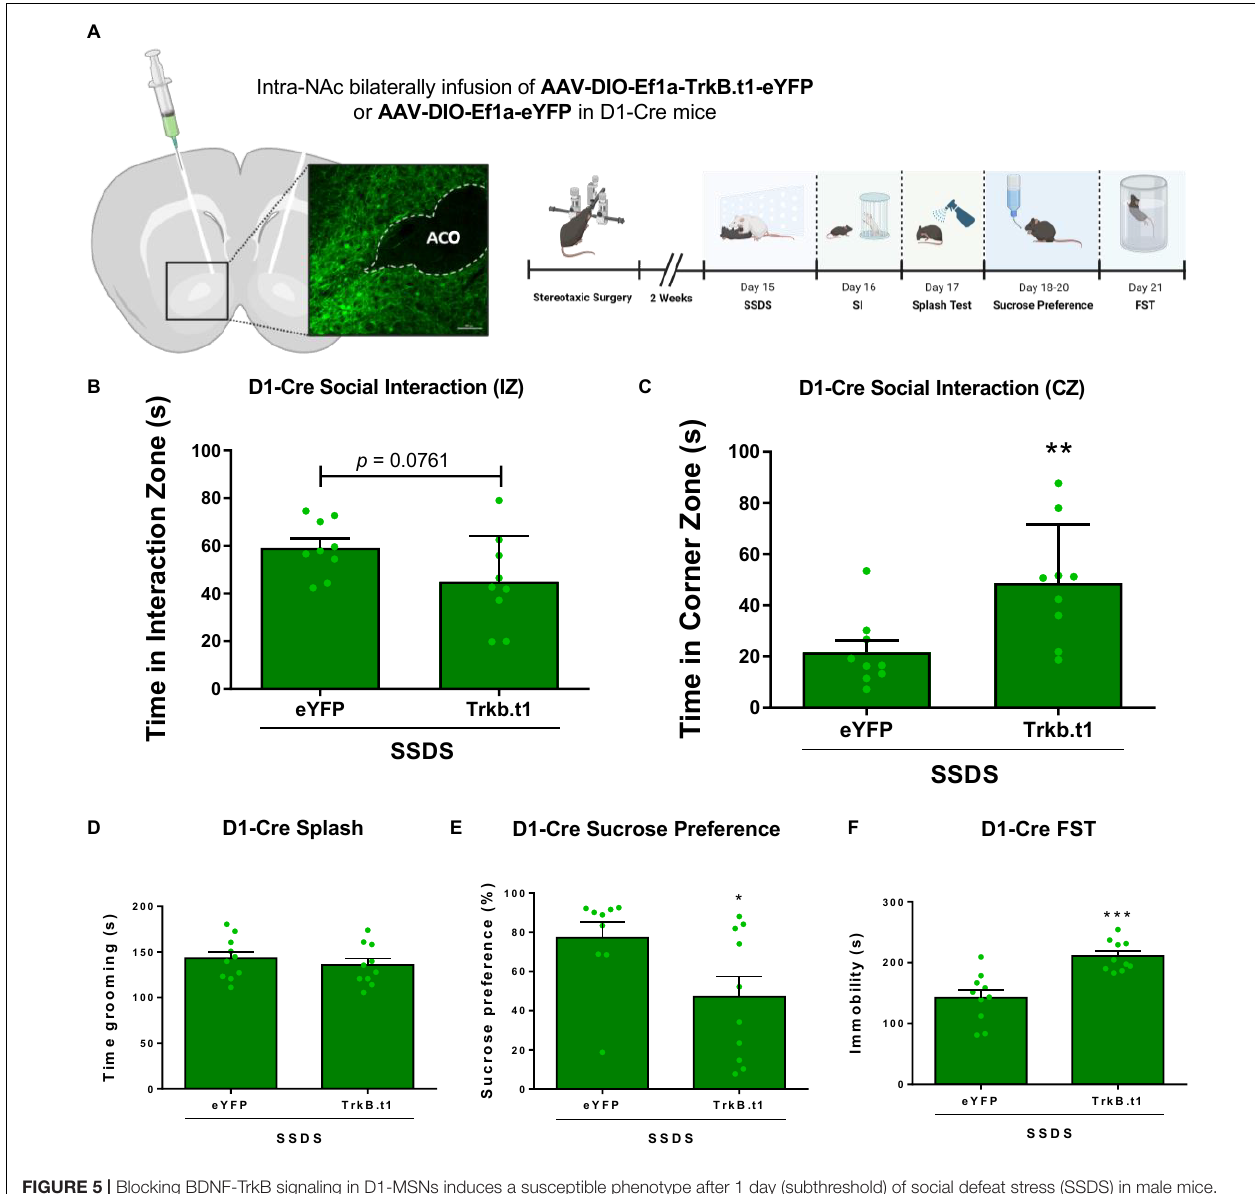
FIGURE 5 | Blocking BDNF-TrkB signaling in D1-MSNs induces a susceptible phenotype after 1 day (subthreshold) of social defeat stress (SSDS) in male mice. (A) Viral vectors and image demonstrating the viral injection, with EYFP expression virus, scale bar = 100 µ m. (B,C) SSDS-TrkB.t1 mice spent less time in the interaction zone and more time in the corner zone during the target session of the social interaction test after SSDS ( N = 9 per group). (D) Total time grooming during the sucrose splash test was not significantly different across groups ( N = 10 per group). (E) SSDS-TrkB.t1 mice showed less preference for the sucrose solution when compared with SSDS-eYFP ( N = 9–10). (F) SSDS-TrkB.t1 mice showed more time immobile when compared with SSDS-eYFP ( N = 9–10) (* p ≤ 0.05; ** p ≤ 0.01; *** p ≤ 0.001; SSDS, subthreshold social defeat stress; SI, social interaction test; Splash, sucrose splash test; FST, forced swim